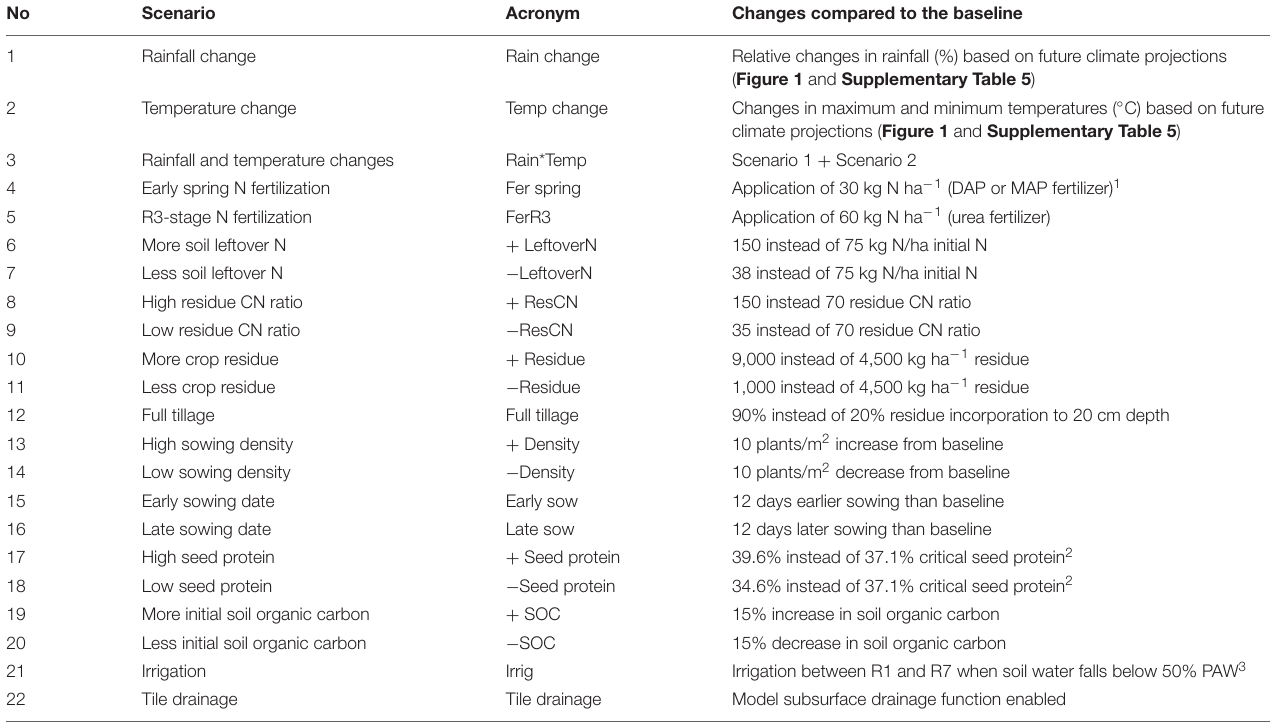
TABLE 1 | GxExM scenarios assessed using